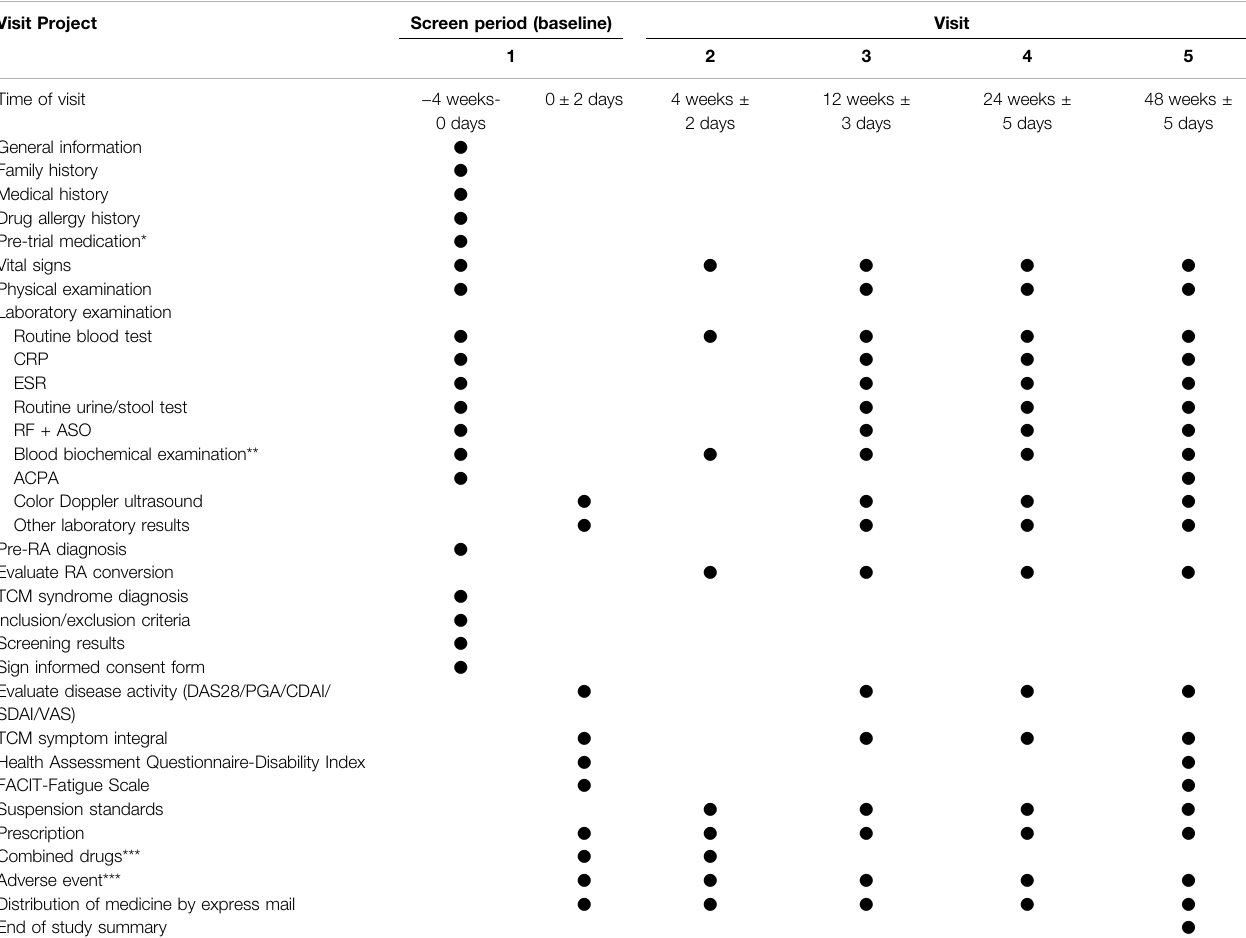
TABLE 3 | Study procedure